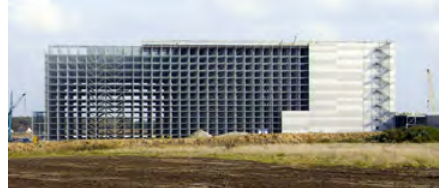
Figure 4. Example of a warehouse building under construction ( Google Maps [2]).